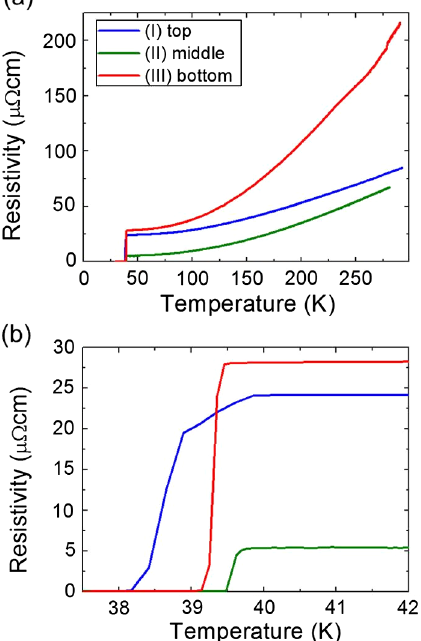
FIG. 6 (color online). (a) Resistivity versus temperature for a set of MgB 2 films grown on c-cut sapphire substrates mounted at different locations of the stainless steel tube. (b) Close-up of the transition edge.